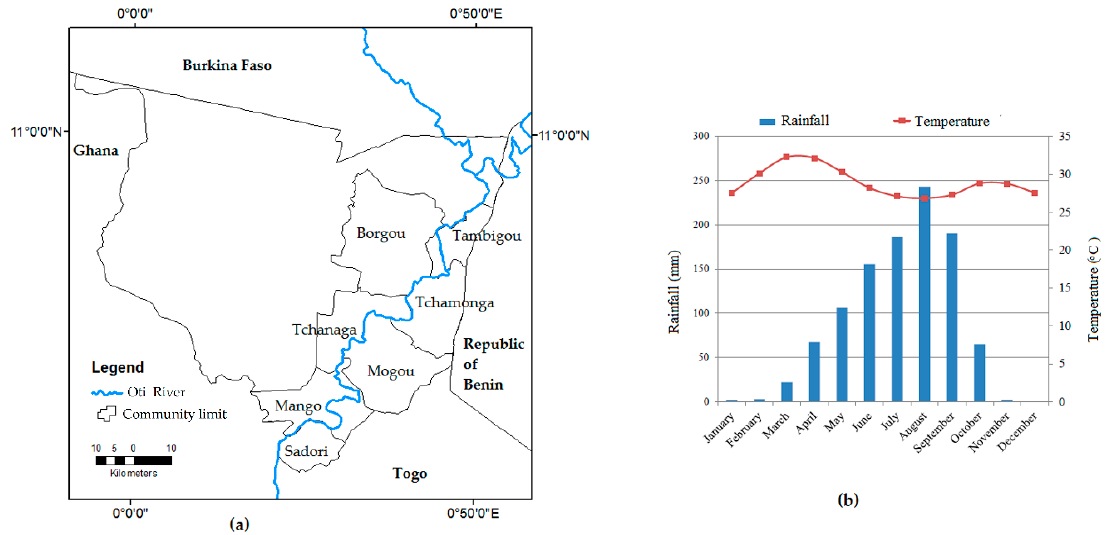
Figure 1. ( a ) location of the study area; and ( b ) climate diagram at Mango from 1980 to 2010. Table 1. Socio-economic characteristics of the selected communities.